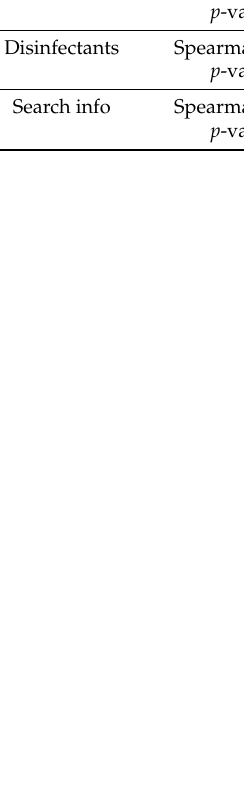
Table 9. Regression model fit measures and